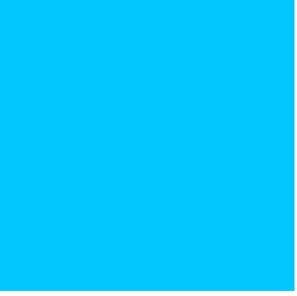
Figure 8. The optimal color solution.